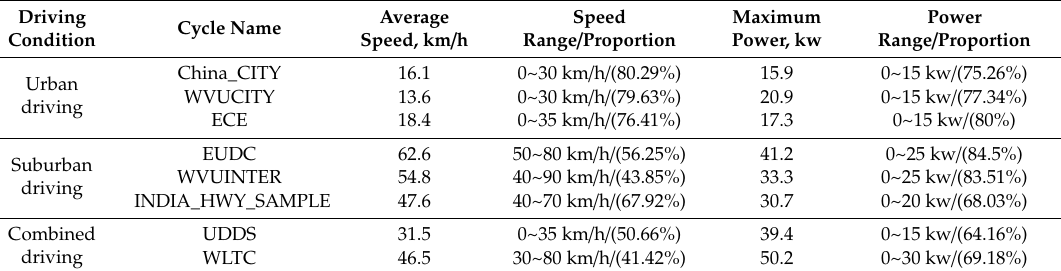
Table 3. Data statistics of typical vehicle driving conditions.